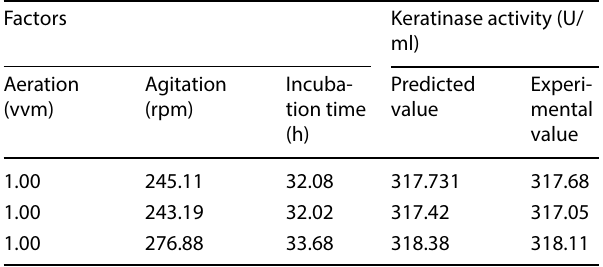
Table 5 Validation of the response surface model within the design space Factors Keratinase activity (U/